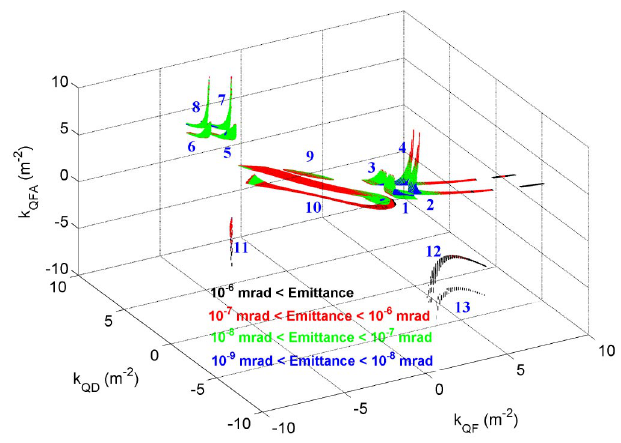
FIG. 3. (Color) Emittance of all linear stable solutions in plotted k -space for one of the 12 ALS TBA sectors. because the bunch length and longitudinal bunch shape depend upon its value. As with the previous example, we plot the momentum compaction of stable solutions in Fig. 4. For an ALS lattice the values of the momentum compaction factor can be positive or negative and range from (cid:1) 0 : 004 to 0.008. The nominal ALS lattice momen- tum compaction is 0.001 37. There are lattices in 3 regions that support small momentum compaction values—re- gions 2, 4, and 10. In fact, in region 10 there are two small momentum compaction areas. Discovering all these differ- ent regions was a surprise. Previously we had known of only one of these regions—one of the two areas in region 10. Even though each of these lattices shares the property of small momentum compaction, some of their other proper- ties are rather different. For instance, some have small emittance while others have large.